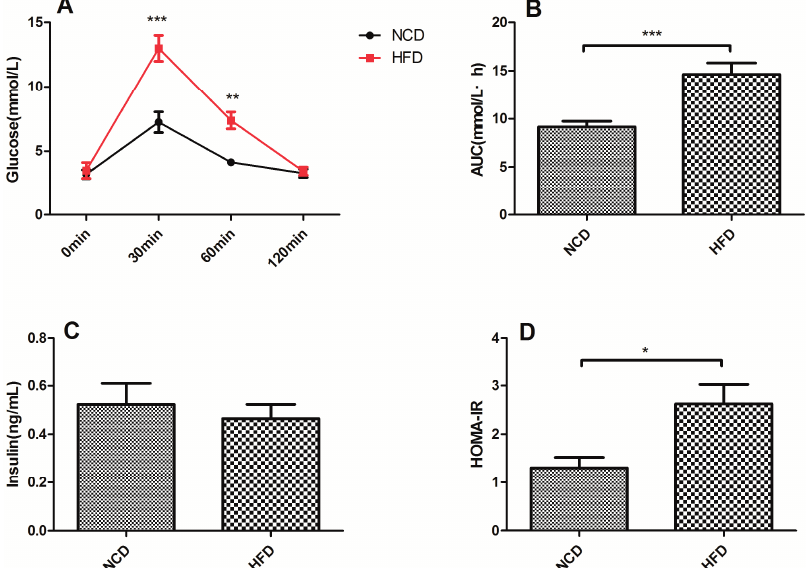
Figure 2. Glucose metabolism parameters of the offspring at weaning in the high-fat diet and normal chow diet groups. ( A ) IPGTT; ( B ) AUC; ( C ) Serum insulin levels; ( D ) HOMA-IR. Data represented as the mean ± S.D. ( n =16, per group, 8 male and 8 female). * p < 0.05, ** p < 0.01, *** p < 0.001 vs. the normal chow diet group. HFD, high-fat diet; NCD, normal chow diet; IPGTT, intraperitoneal glucose tolerance test; AUC, area under the curve; HOMA-IR, the homeostasis model assessment of insulin resistance.